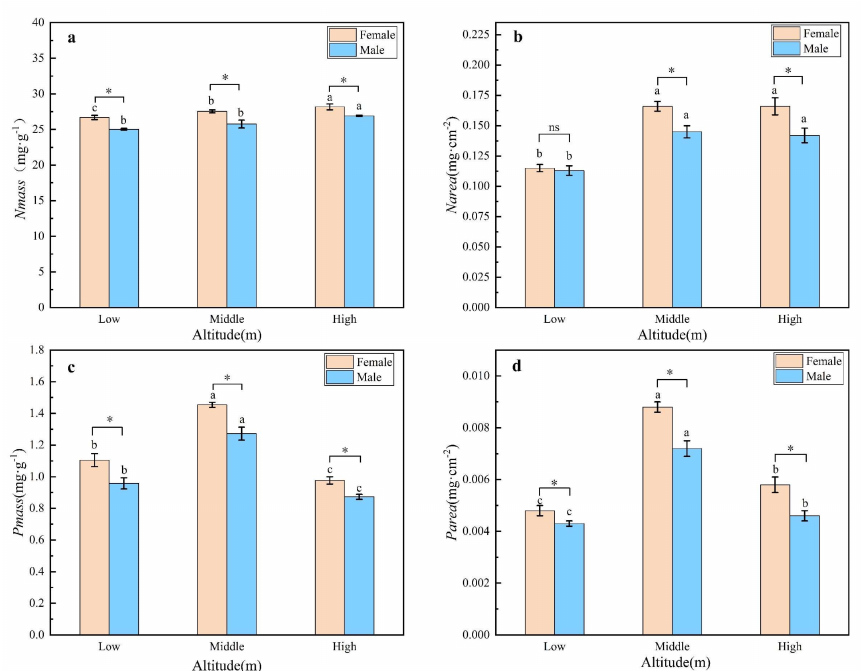
Figure 4. Nutrient indexes of male and female leaves of H. tibetana at different altitudes. ( a ) Nmass of male and female H. tibetana at different altitudes. ( b ) Narea of male and female H. tibetana at different altitudes. ( c ) Pmass of male and female H. tibetana at different altitudes. ( d ) Parea of male and female H. tibetana at different altitudes. Nmass , leaf nitrogen content per unit mass; Narea , leaf nitrogen content per unit area; Pmass , leaf phosphorus content per unit mass; Parea , leaf phosphorus content per unit area. “*” and “ns” indicate significant differences and no significant differences between male and female plants at the same elevation gradient, respectively. a, b, c indicate that there is a significant difference in the mean from large to